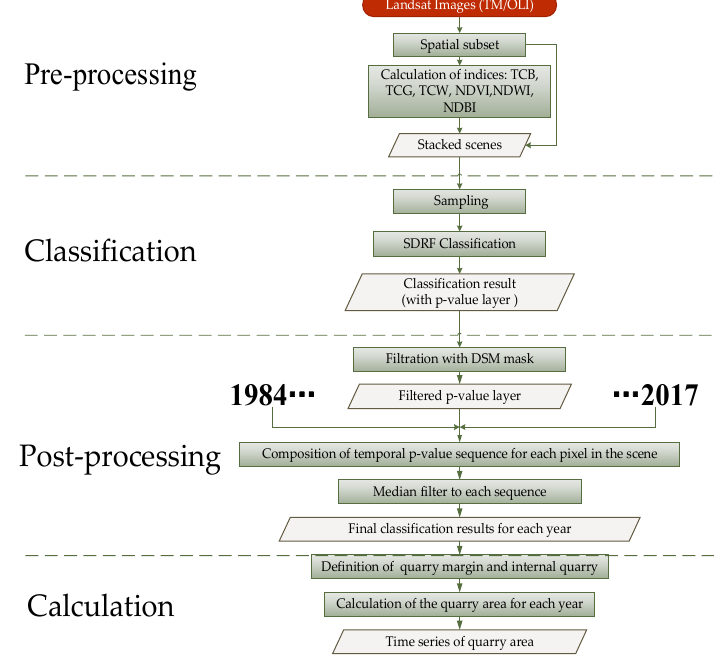
Figure 2. Representation of the methodological framework used in this study.